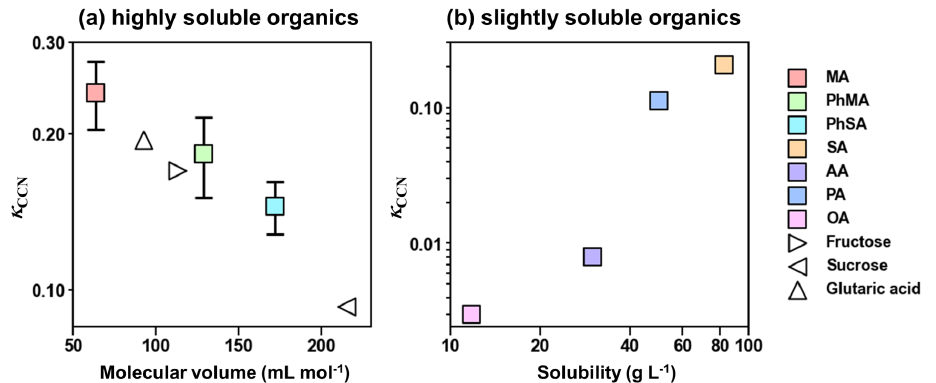
Figure 2. κ CCN of organic compounds as a function of (a) molecular volume and (b) solubility. Solid squares represent κ CCN results in this study, while hollow triangles are κ CCN results obtained from Chan et al.